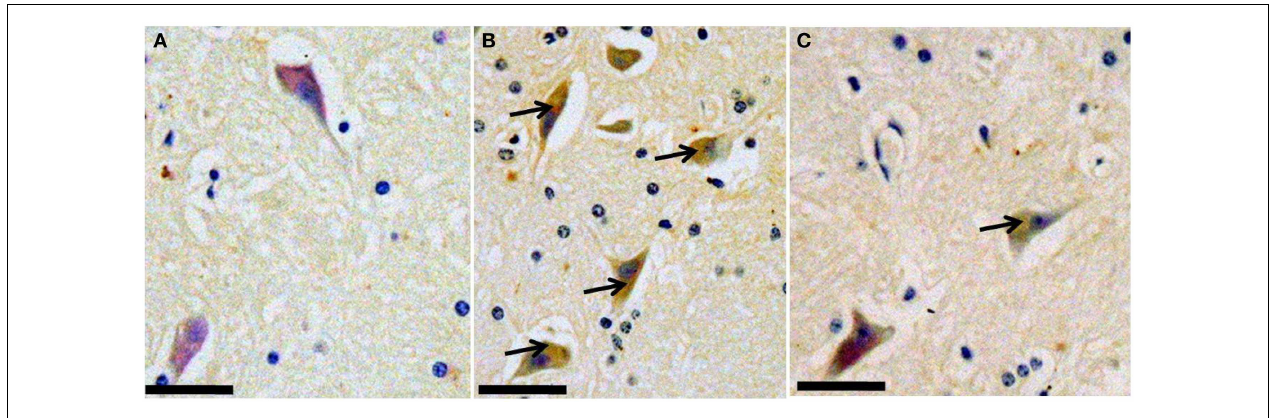
polyclonal serum against human p-tau pT231 and stained with DAB. Arrows indicate the presence of pT231 in the cytoplasm of nerve cells. Scale bars: 60 µ